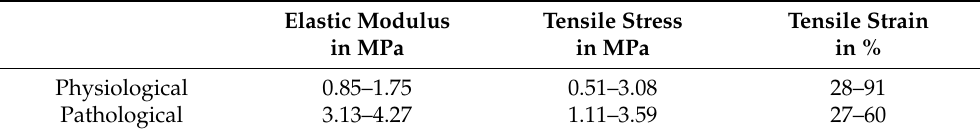
Table 2. Mechanical properties (elastic modulus, tensile stress, and tensile strain) of healthy and atherosclerotic human coronary arteries